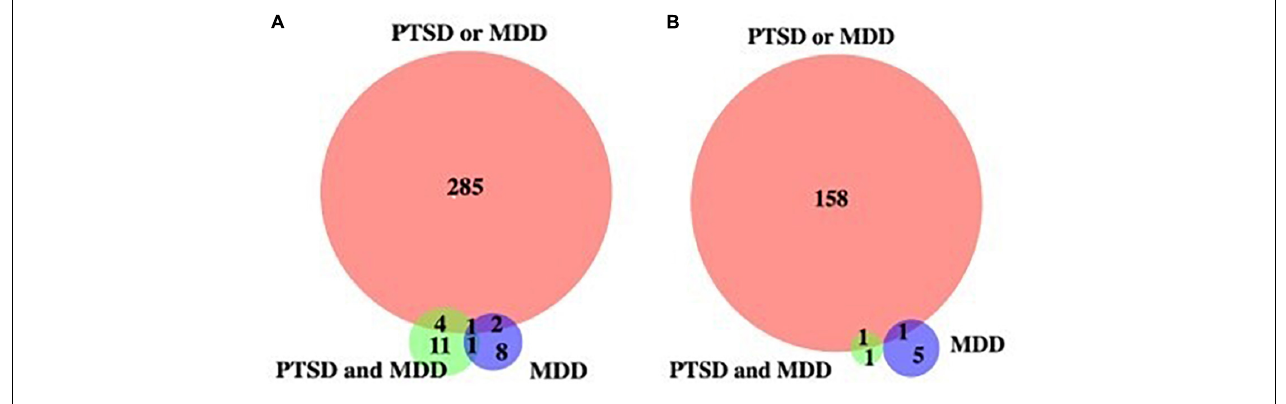
FIGURE 1 | Venn diagram of genes with de-methylated cytosines. (A) Genes with hypermethylated cytosine sites, (B) genes with hypomethylated cytosine sites against control.